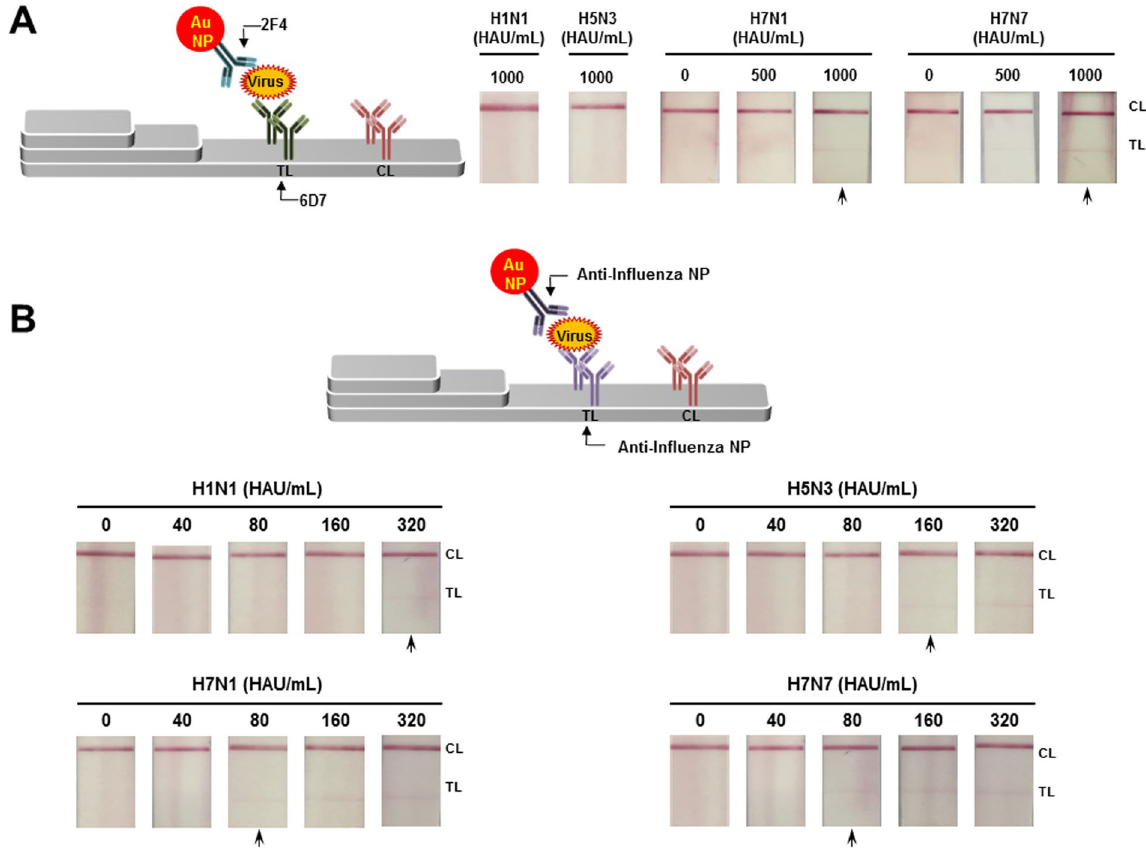
Figure 7. Limit of detection of conventional RDT. The 2F4 mAb conjugated with colloidal gold nanoparticle (Au NP) was captured on the TL (6D7mAb) if there was virus during lateral flow reaction. After 20 min, the strip was read with the naked eye for a binary decision. Two non-H7 subtype viruses (H1N1 and H5N3) were applied in high titer (1,000 HAU/mL) and for two H7 subtype virus (H7N1 and H7N7), 500 and 1,000 HAU/mL of each virus were applied to RDT ( A ). Conventional influenza A RDT targeting influenza A nucleoprotein (NP) was tested with the two-fold serially diluted four subtype virus from 40 to 80 HAU/mL ( B ). The arrow indicates the